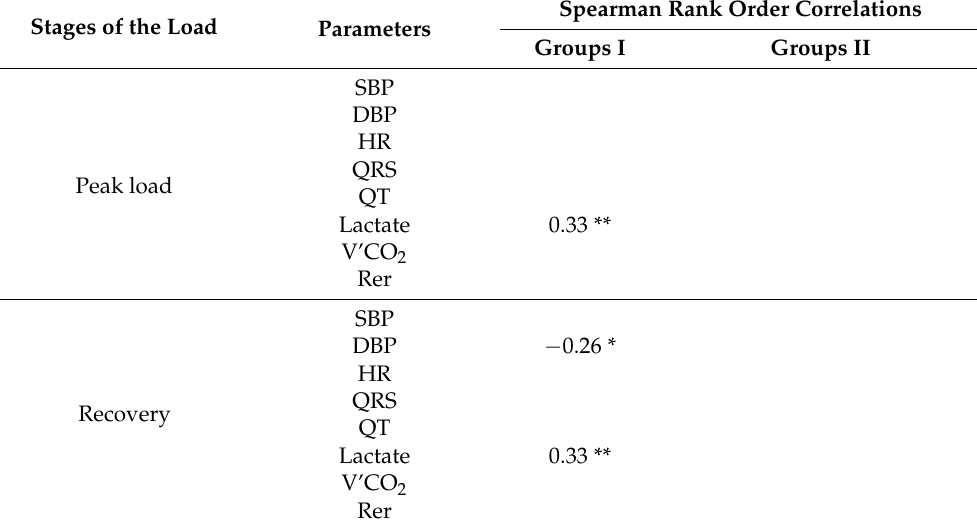
Spearman Rank Order